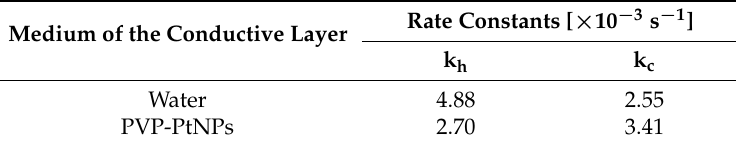
Table 1. Rate constants of heating (k h ) and cooling (k c ) of the circulating